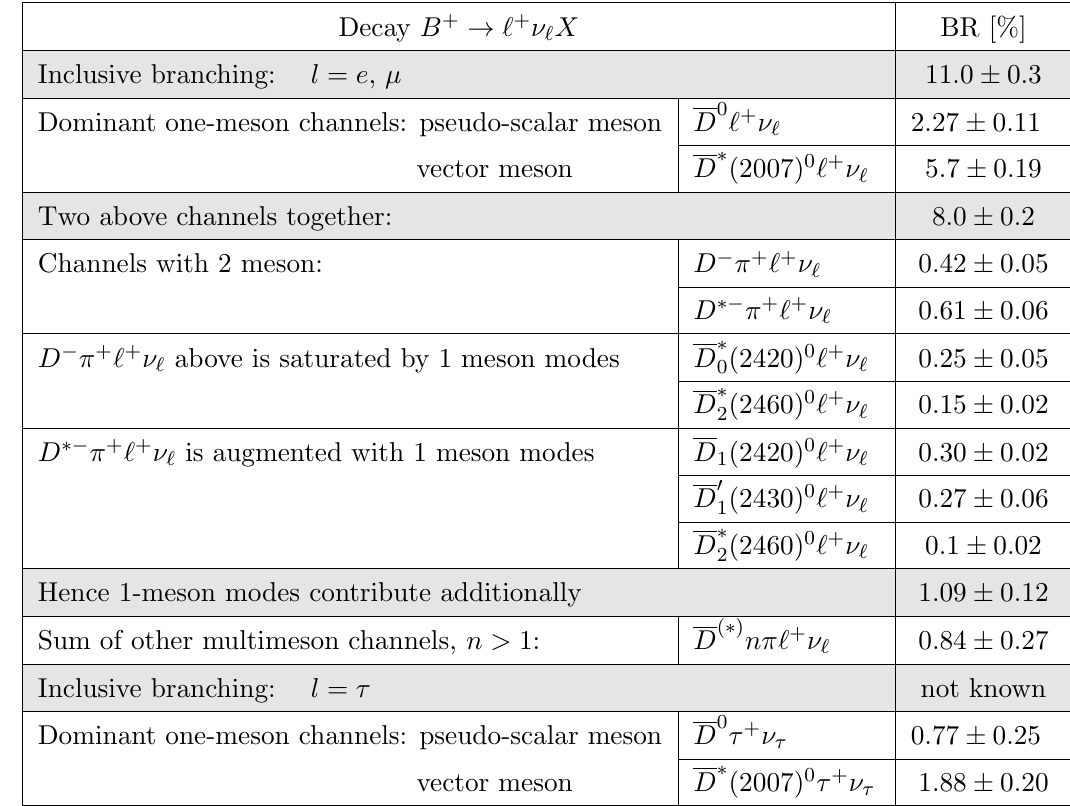
Table 1 . Experimentally measured branching widths for the main semileptonic decay modes of the B + and B 0 meson [65]. Decays to pseudoscalar ( D ) and vector ( D (cid:3) ) mesons together constitute 73% (for B + ) and 69% (for B 0 ). Charmless channels are not shown because of their low contribution.